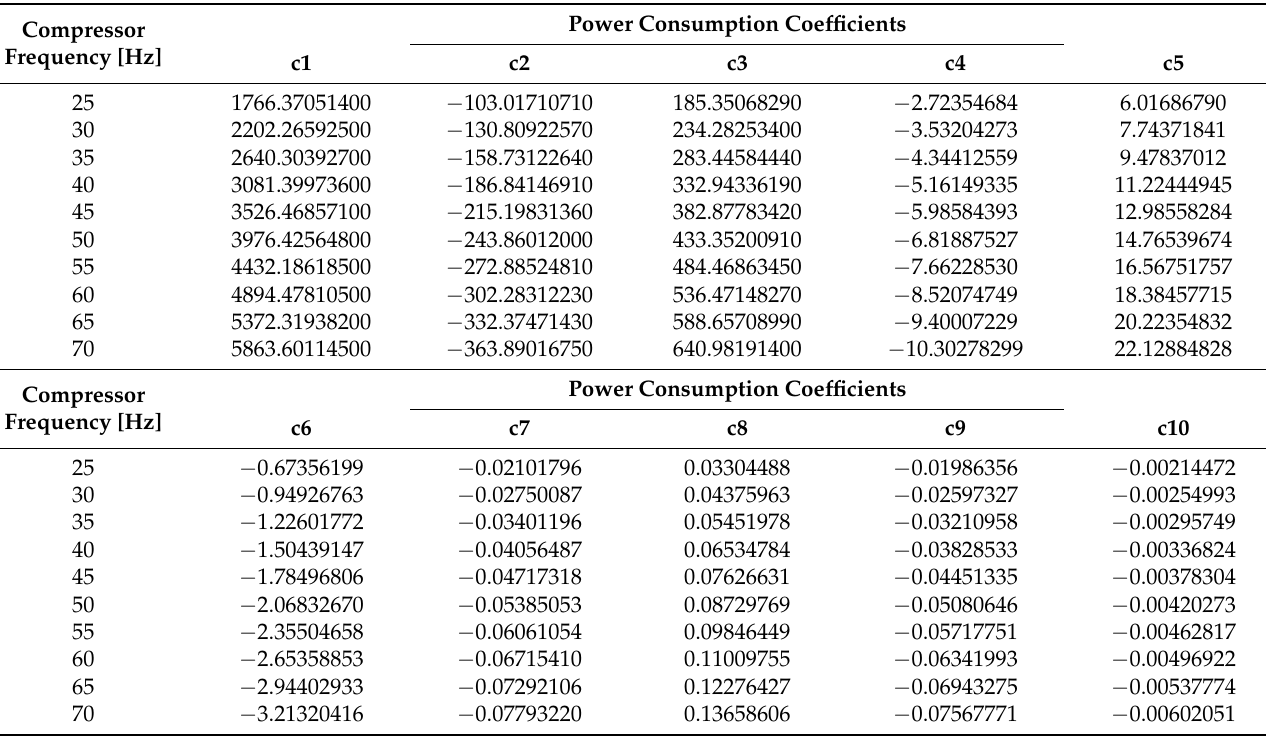
Table A2. Power consumption coefficients at different compressor